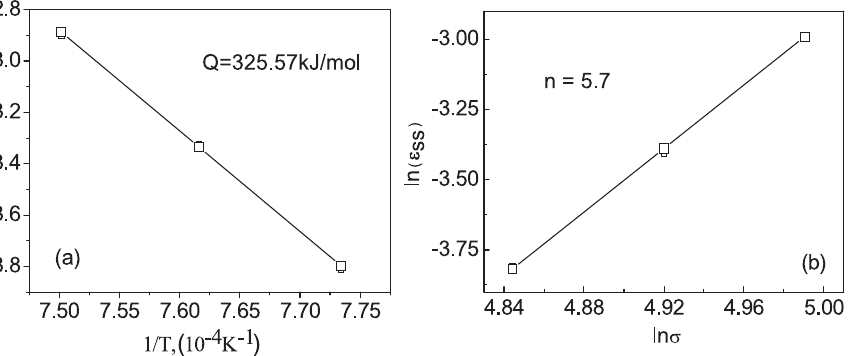
Fig. 3: Relationship between the strain rates and applied temperatures, stresses during steady state creep. (a) Strain rates and temperature, (b) strain rates and applied stress